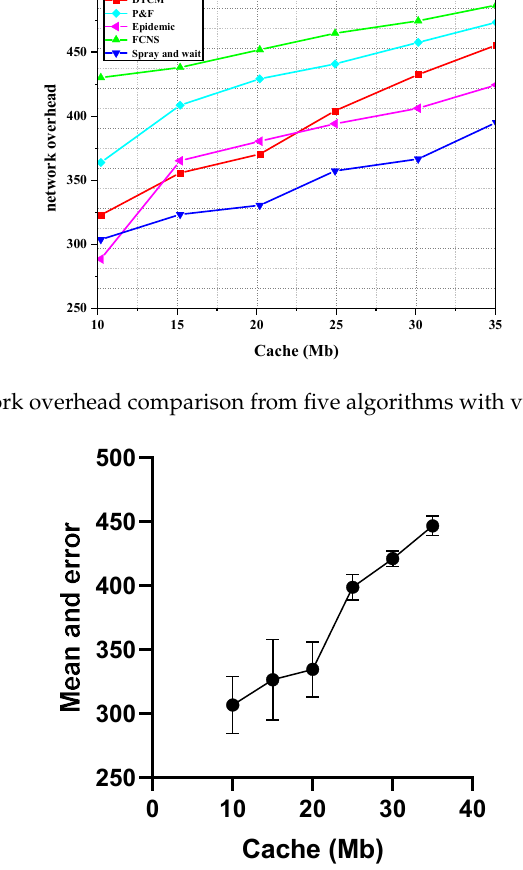
Figure 11. Mean and error from the experiments on network overhead comparison.